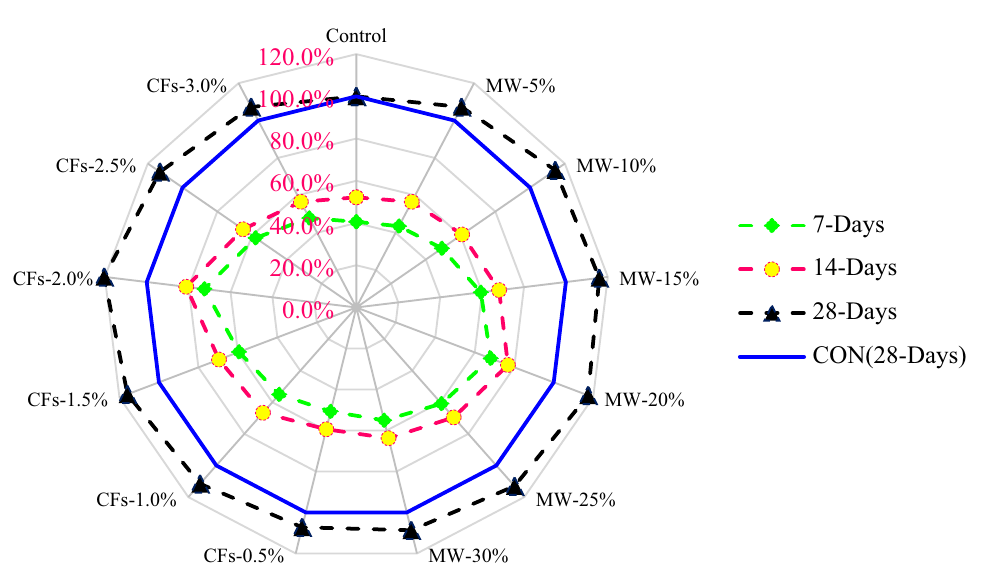
Figure 14. Relative analysis of tensile